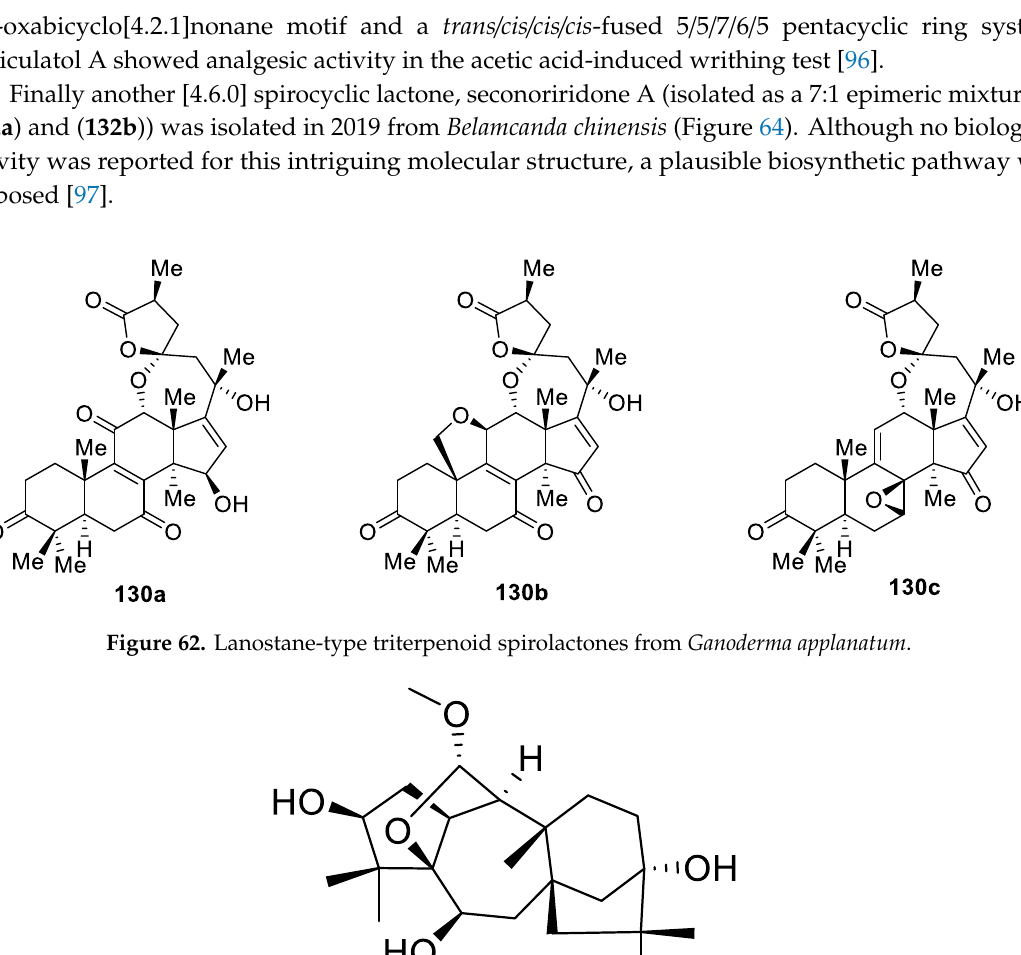
Figure 63. Structure of auriculatol A possessing a [4.6.0] spirocyclic motif.